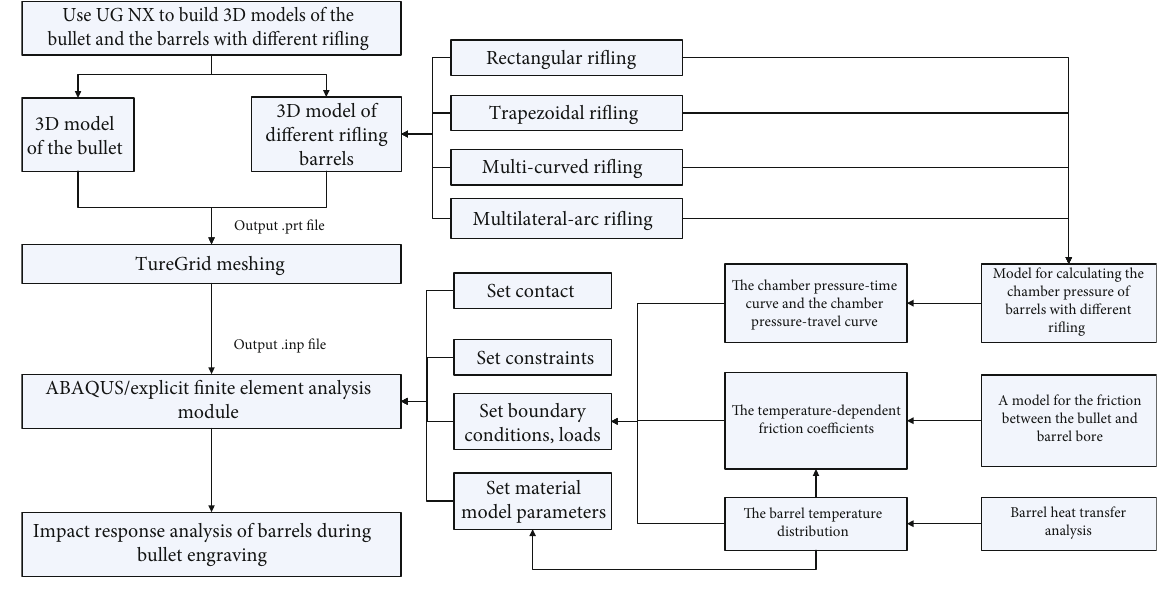
Figure 3: Cosimulation process for the barrel impact response.